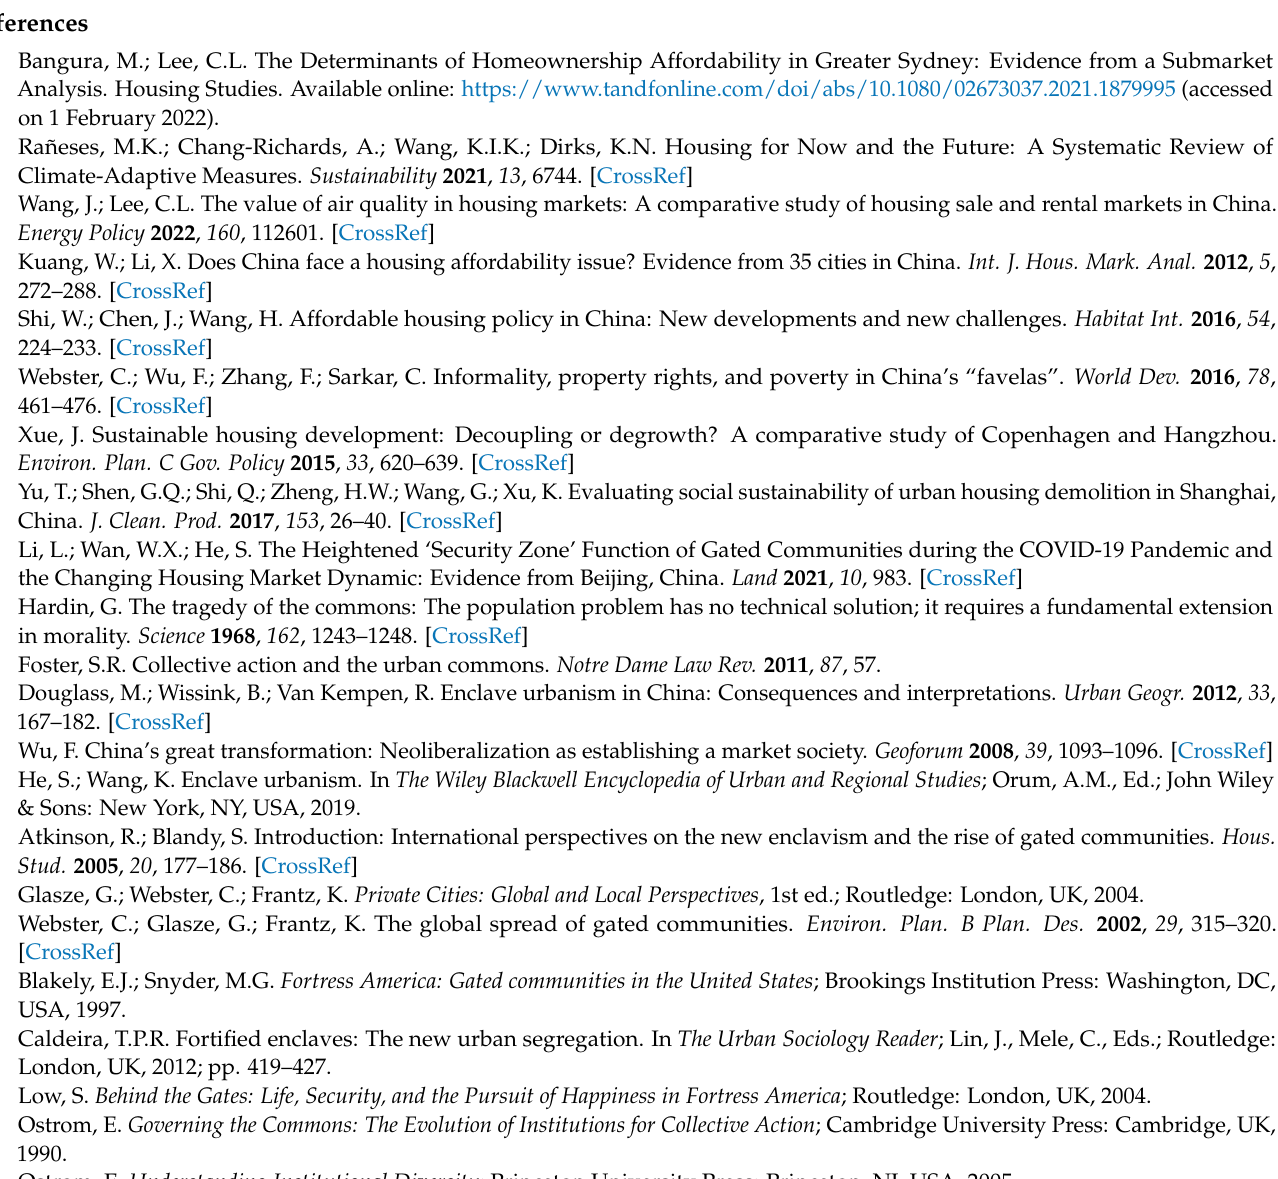
table. c Optimal model: 2. d Selected model/Parsimonious model: